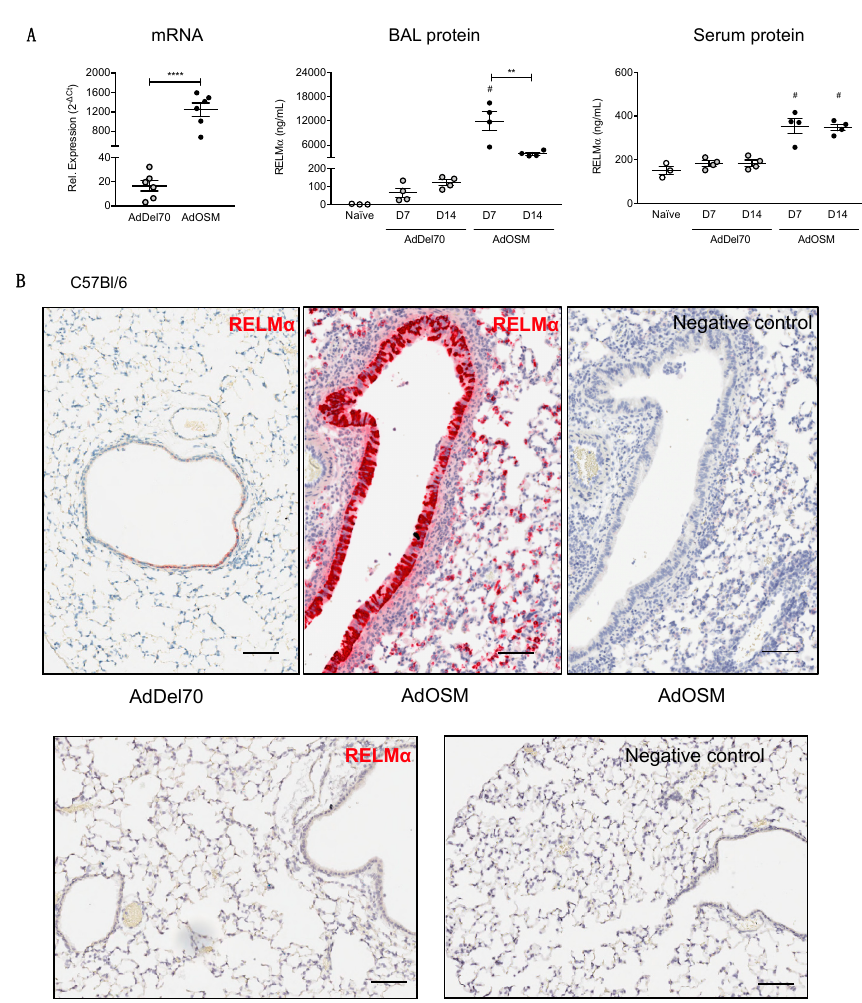
Figure 1. Transient overexpression of OSM induces RELM α mRNA and protein expression in lungs of C57Bl / 6 mice. ( A ) RELM α mRNA levels in total lung extracts, 7 days following administration of AdDel70 or AdOSM, and expressed relative to 18S ribosomal RNA. RELM α protein levels in BAL fluid (middle panel) and serum (right panel) 7 and 14 days post-infection (D7,D14) were assessed by ELISA. Data are expressed as mean ± SEM ( n = 3–6 mice / group). Statistical significance determined by one-way ANOVA with Tukey’s post hoc test ( # p < 0.05 relative to controls at the indicated time point; ** p < 0.01, **** p < 0.0001 between indicated groups). ( B ) Chromogenic in situ hybridization (CISH) of mouse lung sections at day 7 of AdDel70 (top left panel) or AdOSM (top middle panel) using specific RELM α probe. The top right panel shows a serial section adjacent to the middle panel processed without the RELM α probe. Bottom panels show naïve lung sections with RELM α probe (left) or no probe (right). Scale bars, 50 µm.